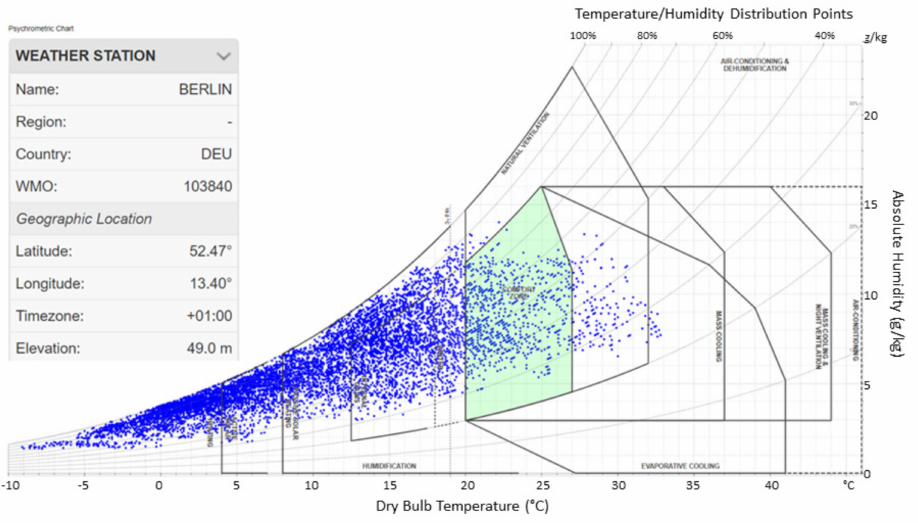
Figure 6. Hourly psychometric chart with Givoni Bioclimatic Chart overlay, Berlin,